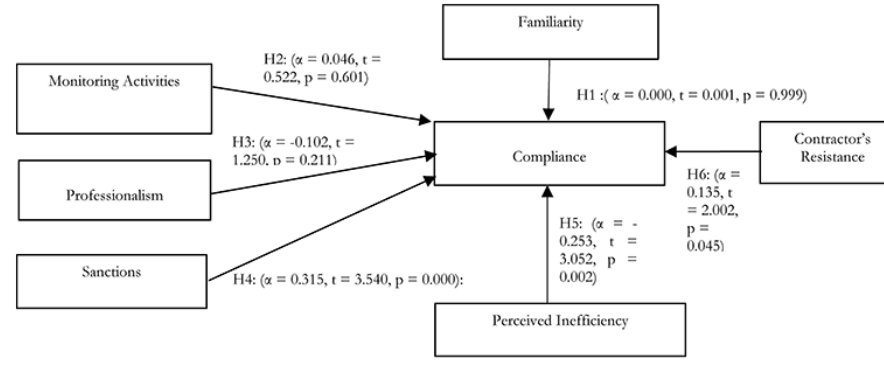
Validated model. (Source: